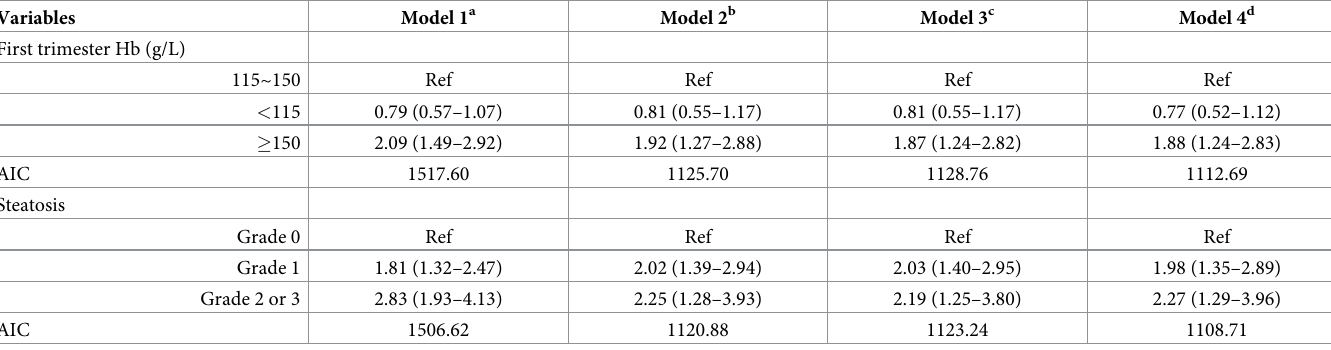
Table 2. OR and 95% CI in univariate and multivariate analysis of steatosis and Hb concentration during the first trimester for developing GDM. Variables